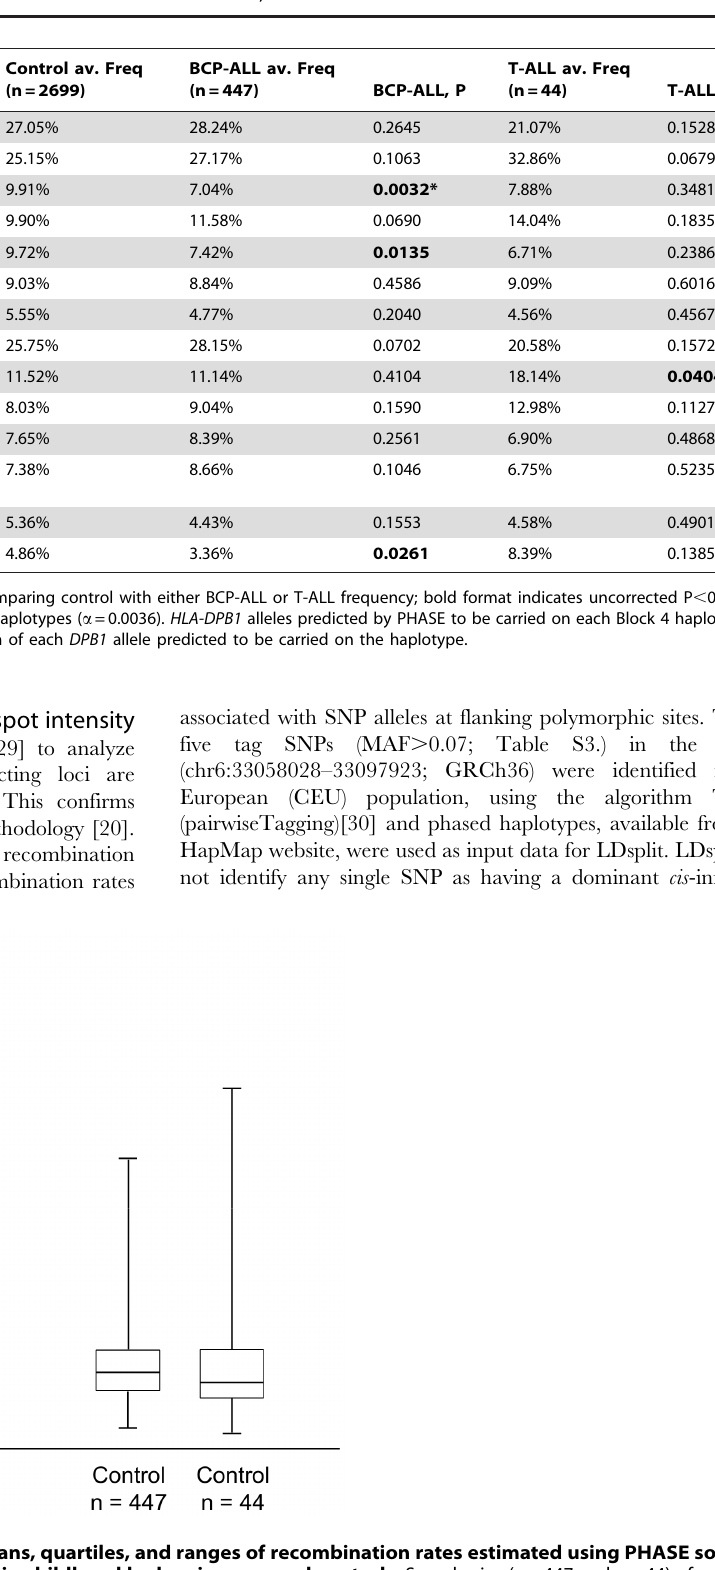
Figure 2. Box and whisker plots illustrating medians, quartiles, and ranges of recombination rates estimated using PHASE software between rs176248 and rs206767 ( DNA3 hotspot) in childhood leukemia cases and controls. Sample size (n=447 and n=44) of randomly selected controls did not significantly affect recombination rate estimates. Relative recombination rates (y- axis) are significantly higher in BCP-ALL (n=447; P=0.02) and significantly lower in T-ALL (n=44; P=0.048) cases than